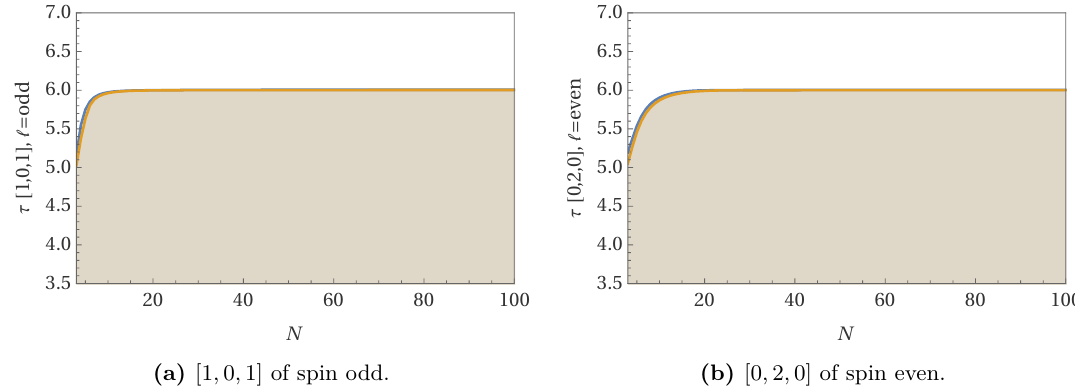
(b) [0 , 2 , 0] of spin even.